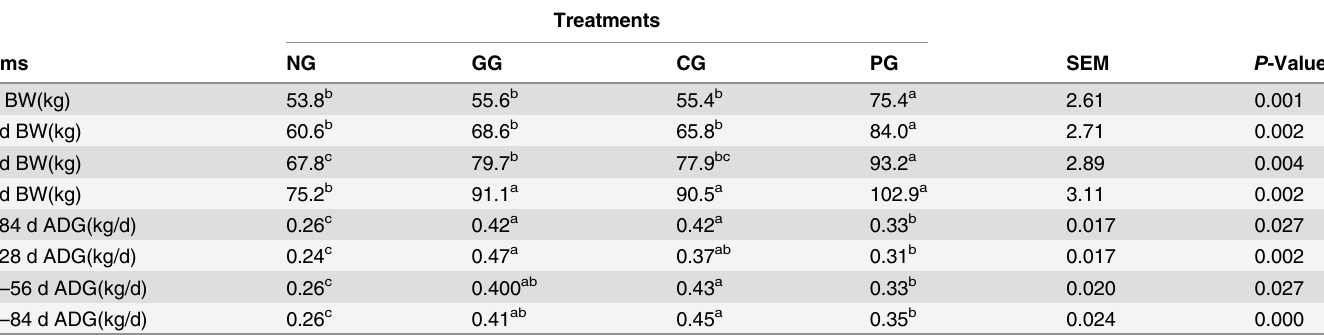
Table 4. Effects of GHRP-2 and CS on growth performance in yaks with growth retardation.